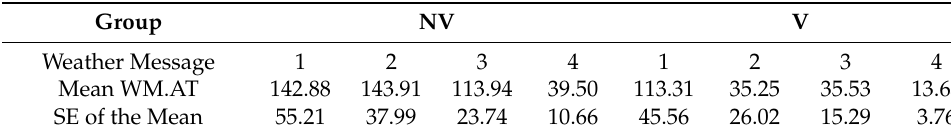
Table 4. Weather message acknowledgement time (WM.AT) (in seconds), divided by group and message number.